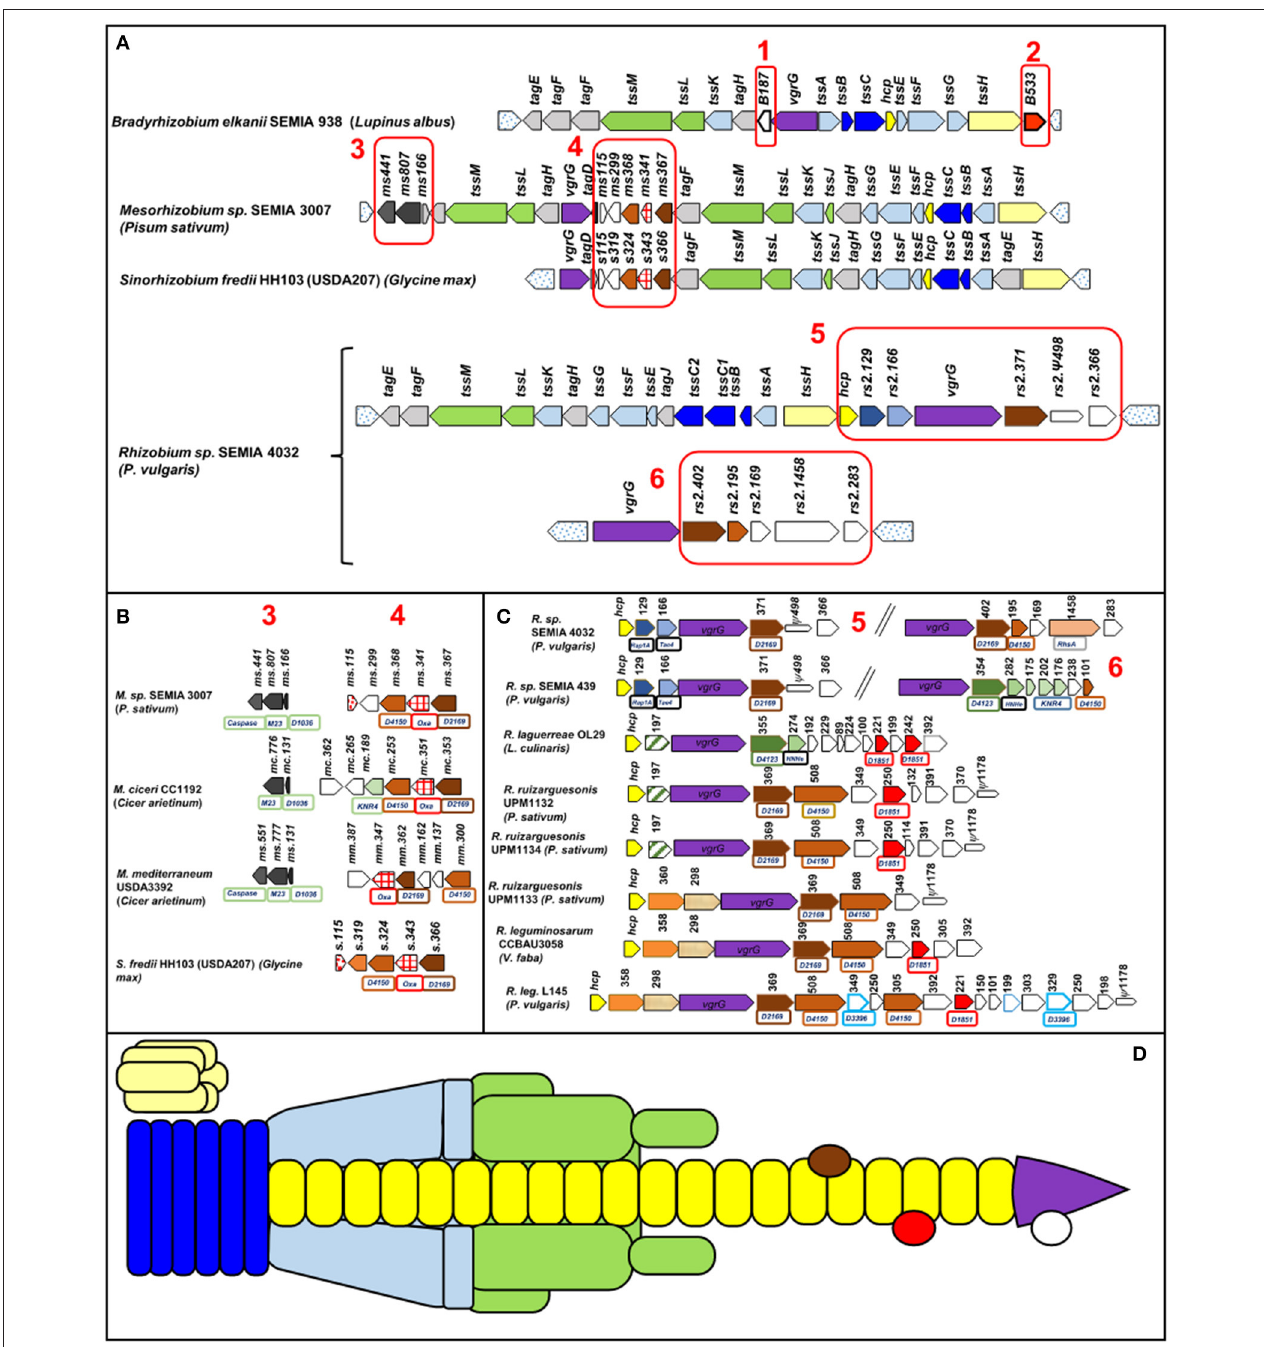
FIGURE 1 | T6SS gene cluster organization of different rhizobia. In parentheses is the host legume. Orthologous genes show the same color and pattern. The numbered Boxes 1–6 contain mainly not tss or tag genes. Box 6 corresponds to strains harboring a second cluster with the vgrG gene. Uncolored genes encode proteins with no known domains. Pseudogenes are indicated by thinner arrows. Dotted arrows have not been considered part of the T6SS. The numbers above the genes indicate the number of amino acids of the corresponding protein and boxes under the genes indicate identified domains ( D : DUF, Oxa: oxoacyl-ACP synthases. (A) General organization in four rhizobia genera, (B) detailed gene organization of Boxes 3,4 of Mesorhizobium and Sinorhizobium strains, (C) detailed gene organization of Boxes 5, 6 of Rhizobium strains, and (D) structure of a T6SS. The colors are the same as those of the genes that encode these units in (A–C) . The effectors are symbolized by ovoid